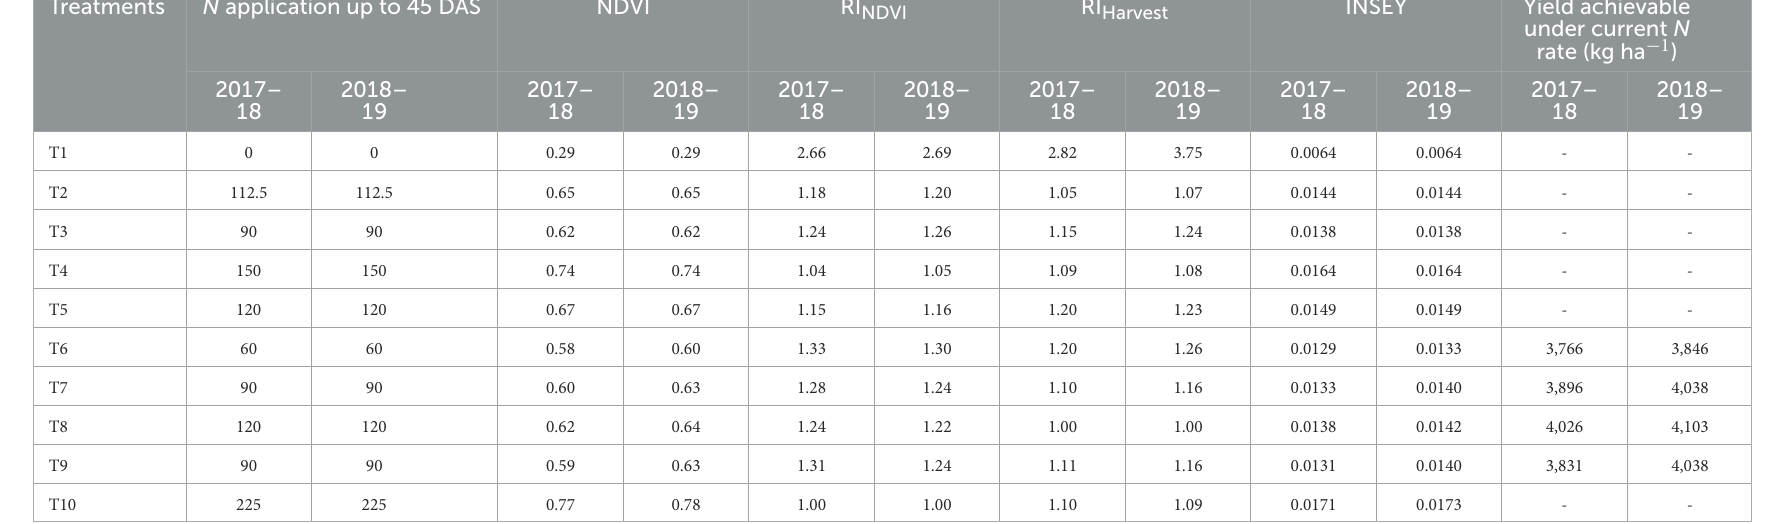
TABLE 1 Evaluation of NDVI sensor-based N management in wheat at 45 days after sowing. Treatments N application up to 45 DAS